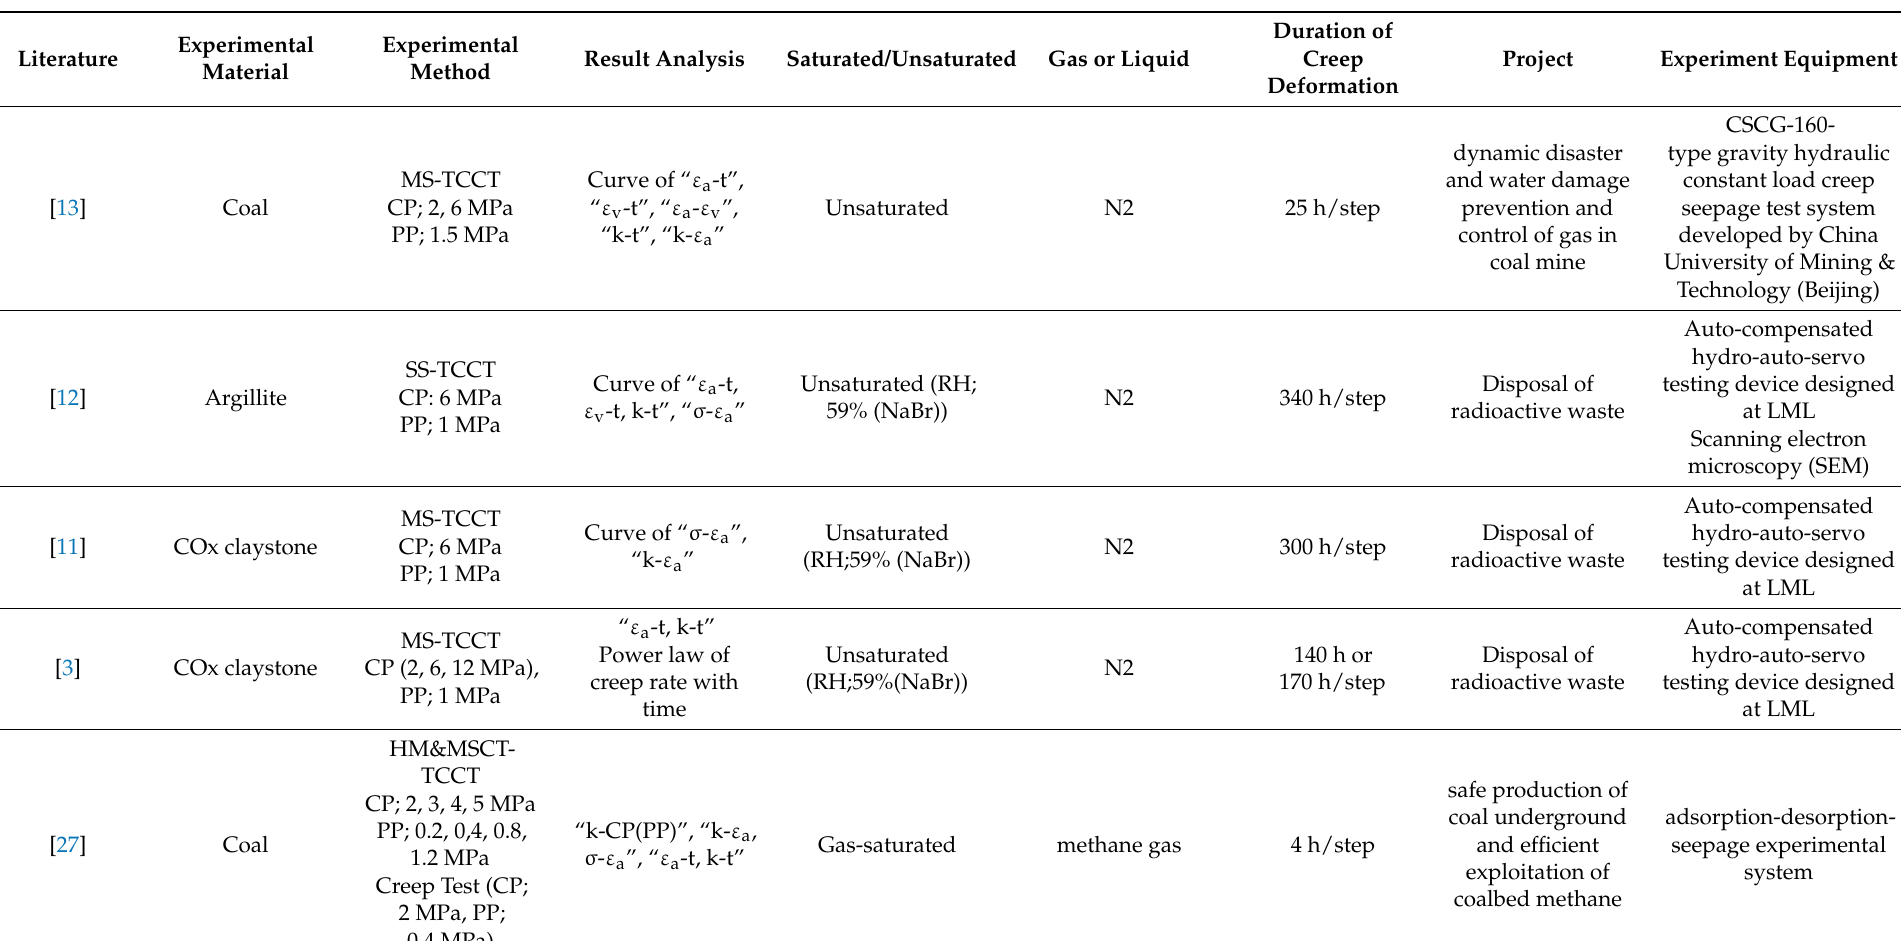
Table 1. Summarization of experimental research for